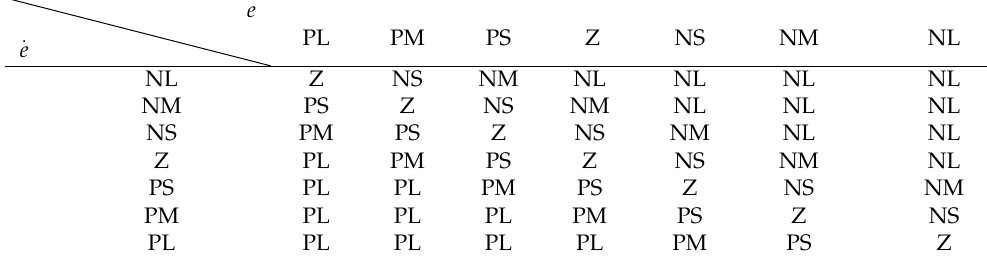
Figure 3. Distance variable.